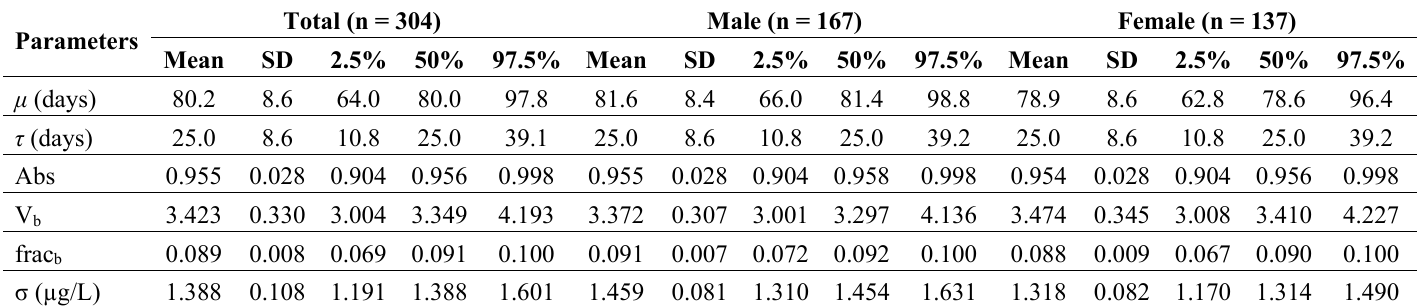
Table 2. Posterior estimates of model